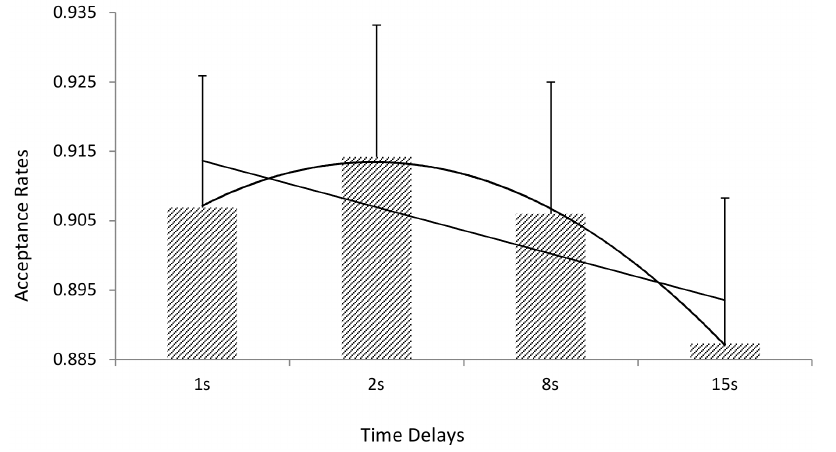
Figure 6. Average Acceptance rates for Different Time Delays for 60:40 Offers. Error bars = standard error of the mean. [Best fitting linear and quadratic trend lines included].